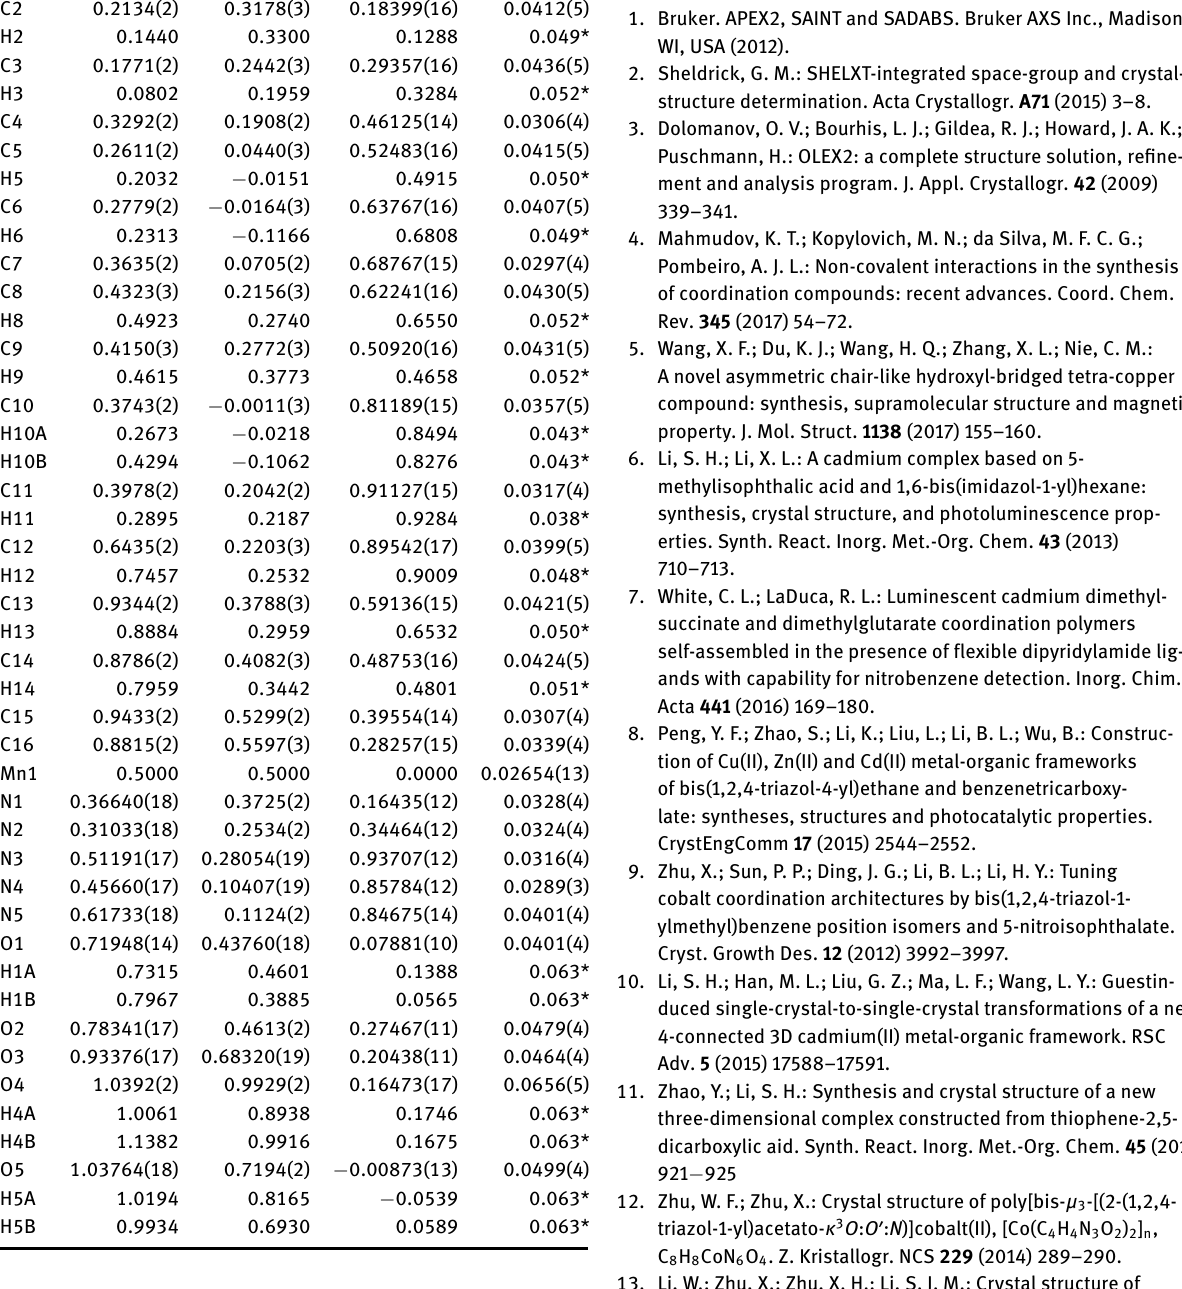
with d(O—H· · · O) = 2.676 − 2.745 Å. Through hydrogen bonds complexes and water molecules are interlinked to form the three-dimensional